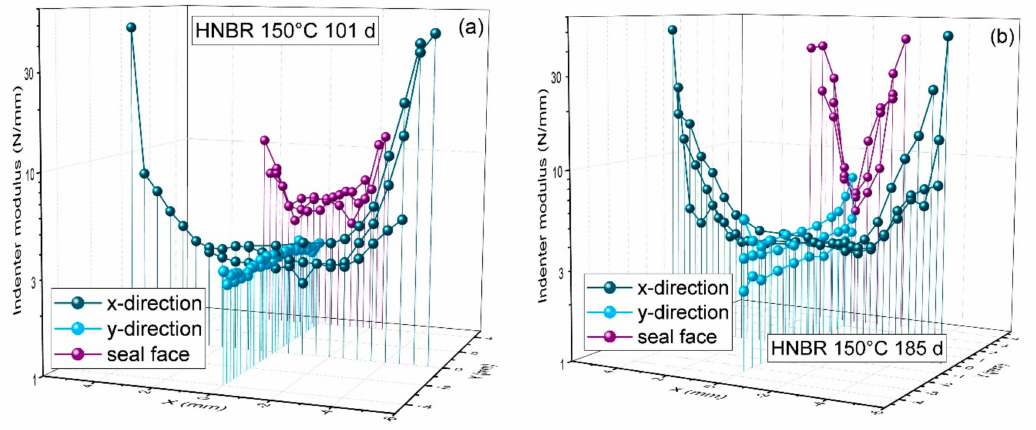
Figure 11. Indenter modulus profiles on the O-ring cross-section in x-direction (dark blue), in y-direction (light blue), and across the seal face in x-direction (purple) determined on HNBR O-rings aged at 150 ◦ C for ( a ) 101 days and ( b ) 185 days (half a